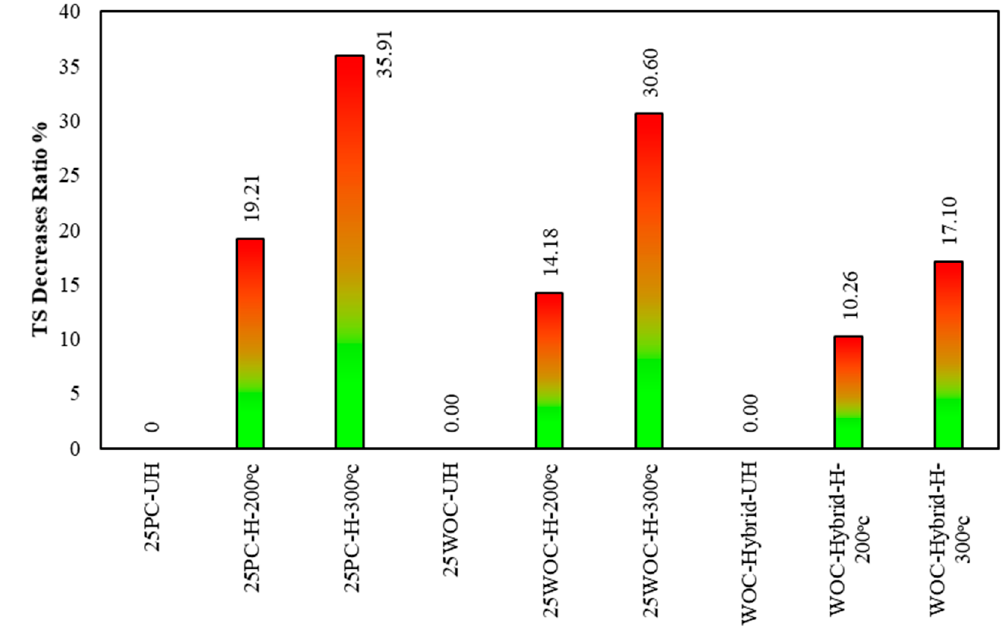
Figure 10. The percentage decrement in tensile strength of PC, WOC, and hybrid specimens at elevated temperatures to samples strength at 25 °C.